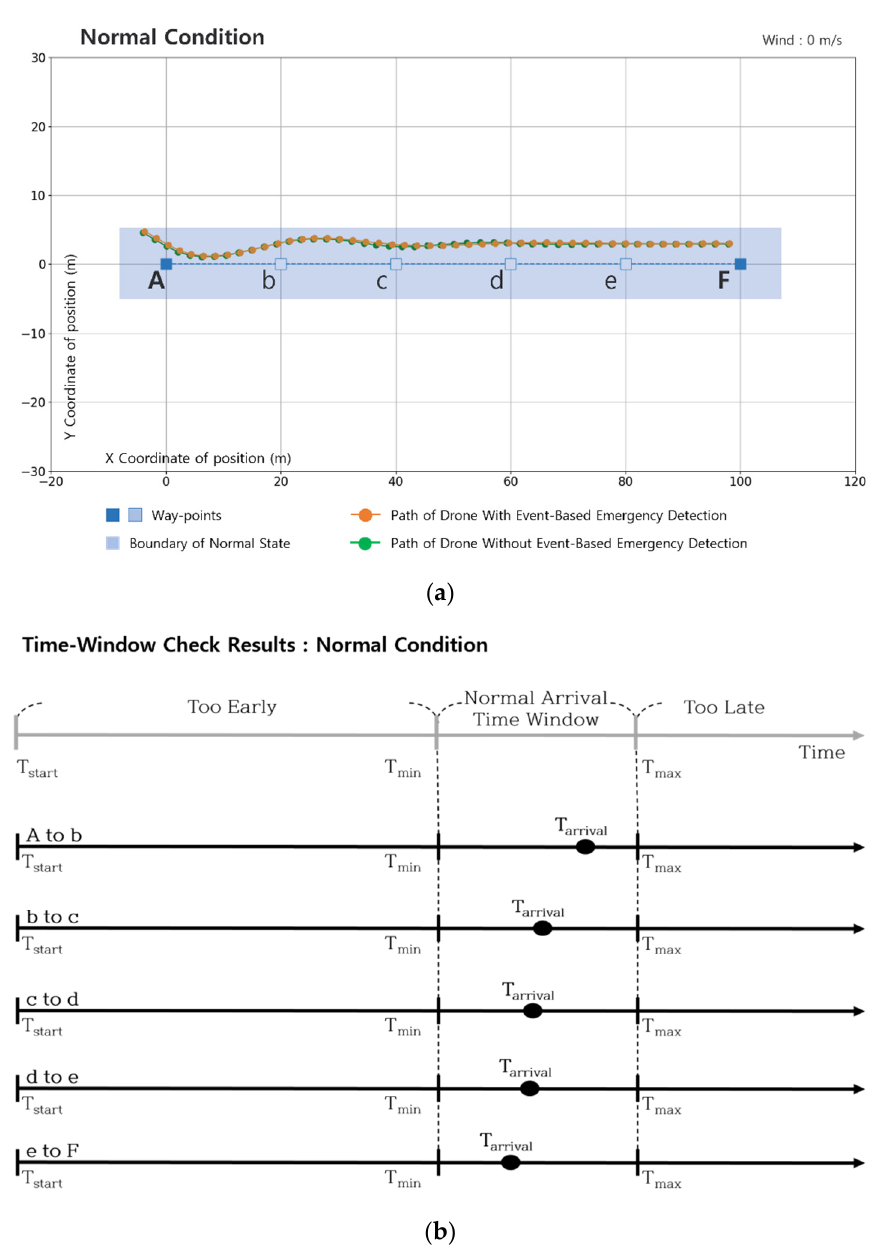
Figure 5. ( a ). Drone movement 2D log on normal case. The results show the drone managed the mission well with no failures. Both the drones with and without an event-based controller showed similar routes. ( b ). Time-window check results. The black dots illustrate the actual arrival time for each waypoint interval relative to each time-window. In this case, the drone made it in all normal arrival time-windows. T arrival showed a decreasing pattern over time as the drone approached the desired speed.